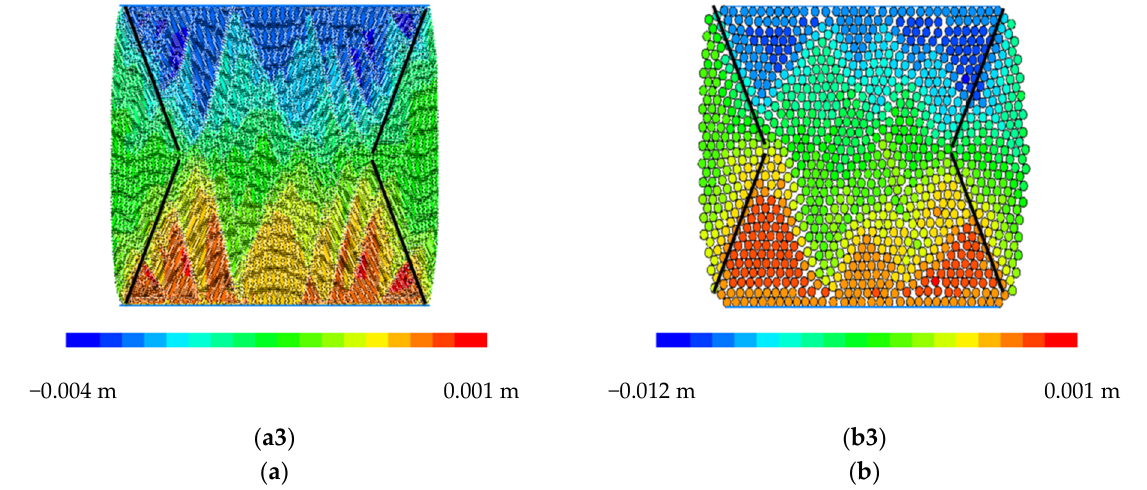
Figure 5. Displacement cloud diagram of concrete specimen after compression. ( a ) 1 mm particle size. ( a1 ) Full displacement. ( a2 ) X direction—lateral displacement. ( a3 ) Y direction—vertical displacement. ( b ) 5 mm particle size. ( b1 ) Full displacement. ( b2 ) X direction—lateral displacement. ( b3 ) Y direction—vertical displacement.